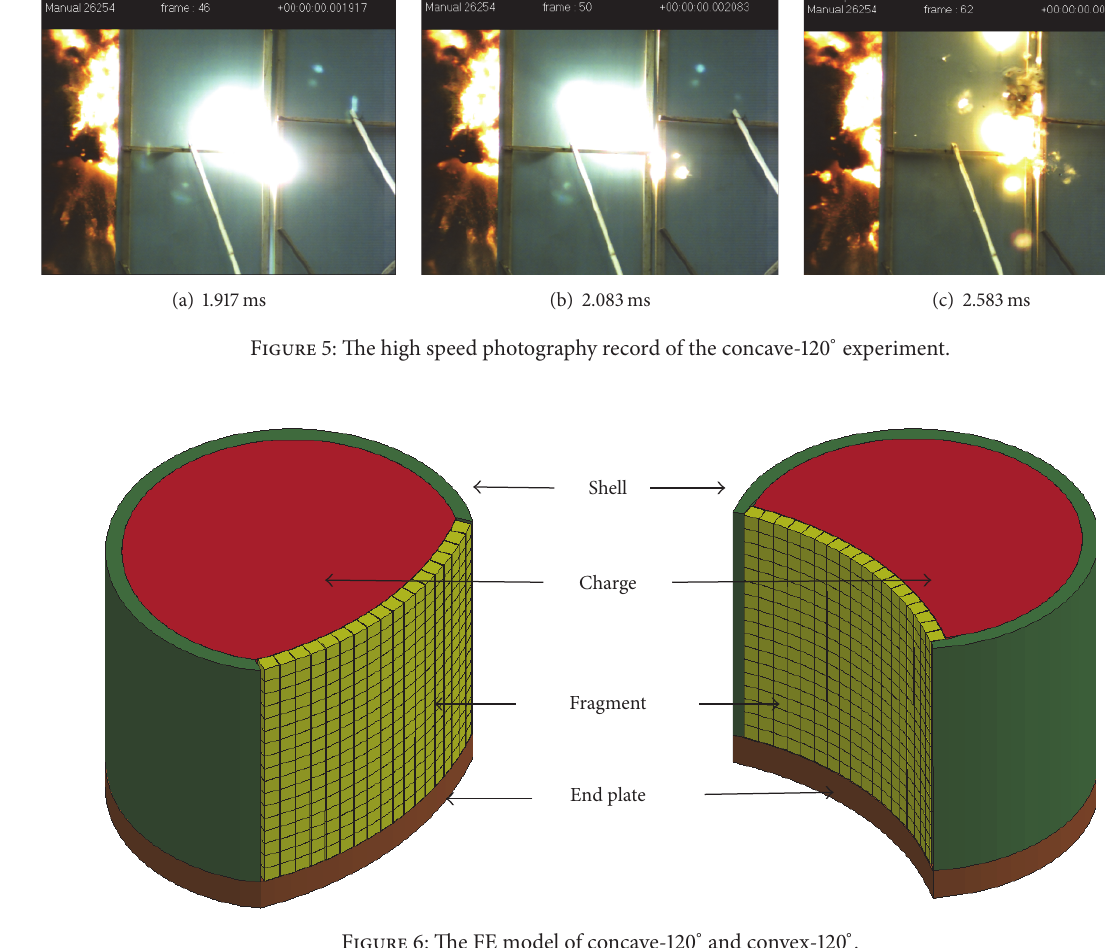
Figure 6: The FE model of concave-120 ∘ and convex-120 ∘ .